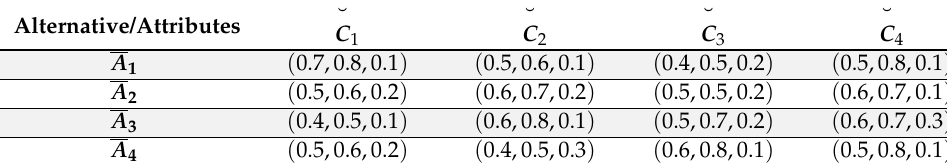
Table 2. T-spherical fuzzy decision matrix A 2 .